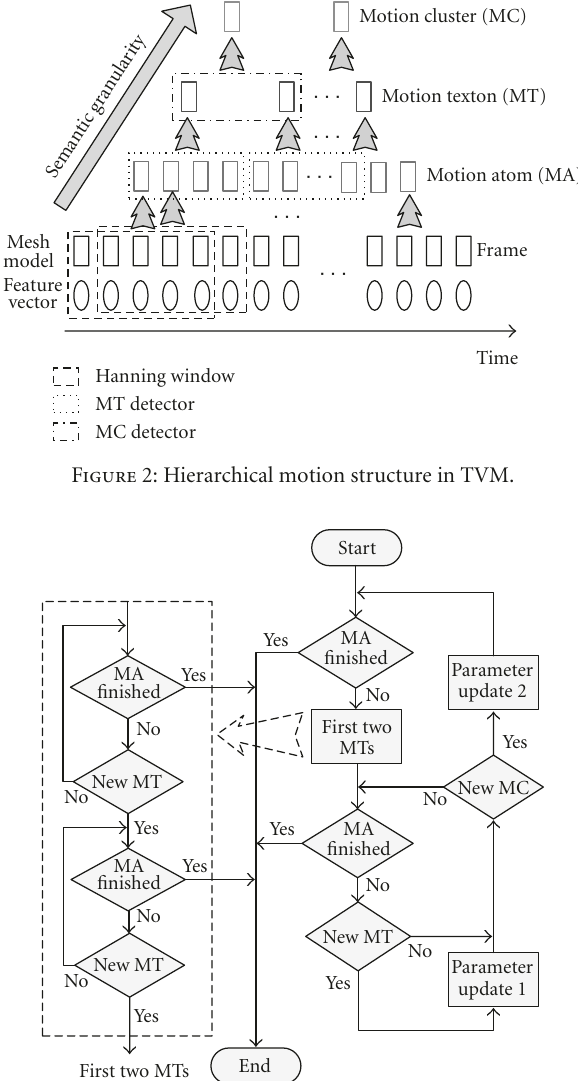
i th texton. Texton distance measures how smooth the